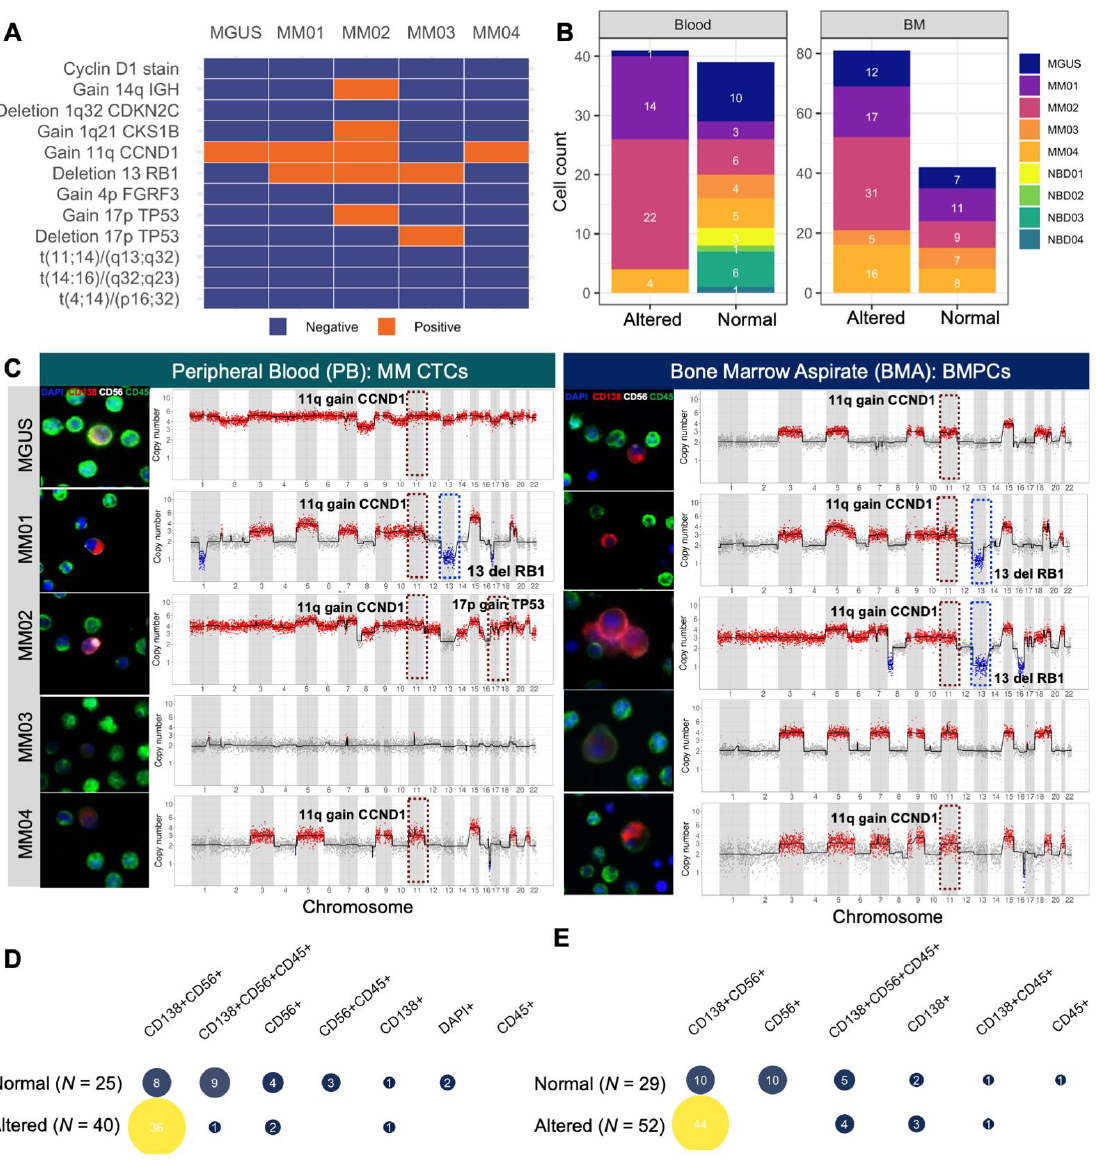
Figure 4. Morphogenomic validation of detected candidate MM CTCs and BMPCs. ( A ). Clinical observations of the status of 12 common cytogenetic events detected by FISH karyotyping across patients’ bone marrow samples. ( B ) Distribution of scCNV profiles across patients and sample types. ( C ) Representative morphological phenotype with corresponding scCNV profiles of subclones containing clinically determined key cytogenetic events. The scCNV profile is for the single CD138+ cell in the corresponding IF image. The red and blue hashed rectangles indicate an alteration event where the patient is also positive by clinical cytogenetics detection. There were no altered cells in MM03 blood. ( D , E ). Single-cell count between normal and altered genomic profiles across morphological groups. A cell is considered altered if the CNV profile contains at least one discernable chromosomal aberration or ploidy.